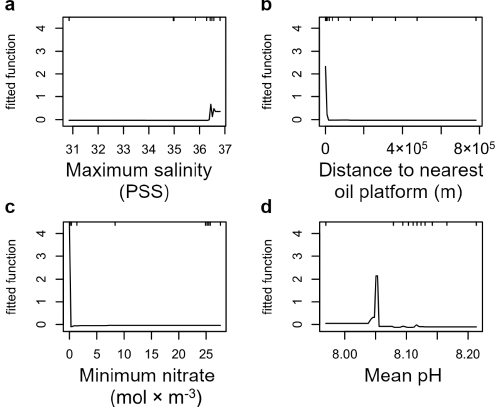
Figure 3. Partial dependence plots for the four variables, ( a ) maximum salinity, ( b ) distance to nearest oil platform, ( c ) minimum nitrate, and ( d ) mean pH, included in the final model. The y-axis represents the logit scale used for the indicated variable; hash marks at the top of the plot indicate deciles of each variable.